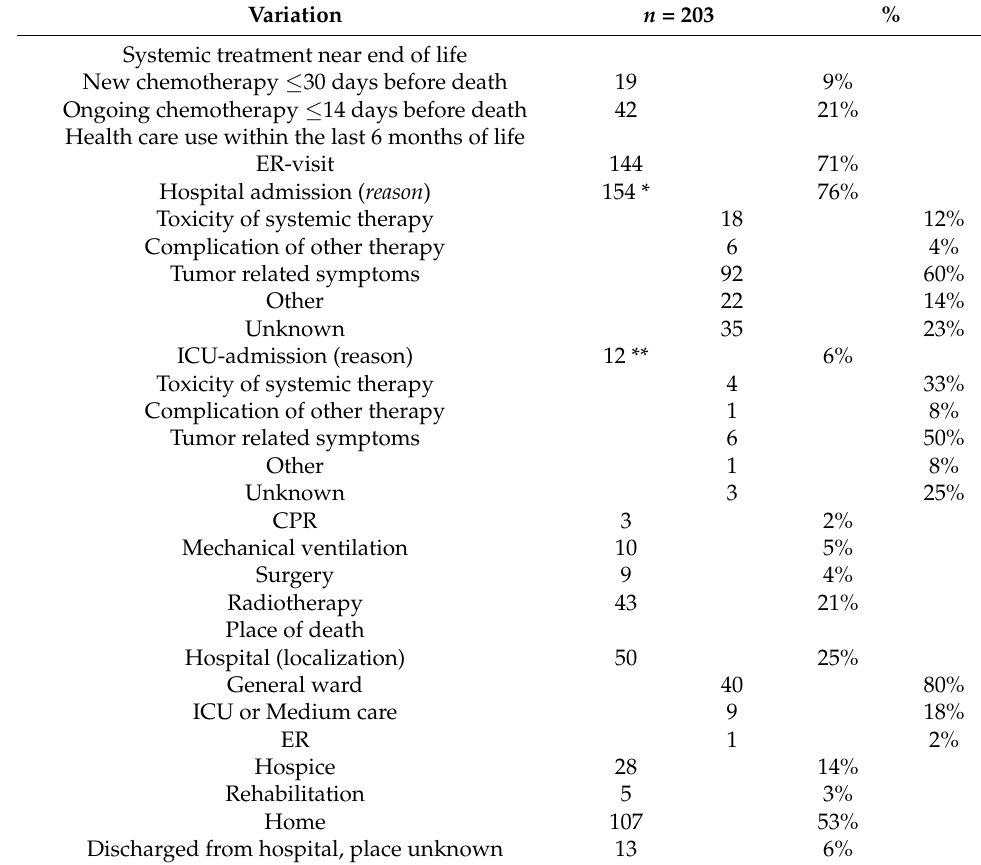
Table 2. Frequency of health care use in the last six months of life. Variation n = 203 % Systemic treatment near end of life New chemotherapy ≤ 30 days before death 19 9% Ongoing chemotherapy ≤ 14 days before death 42